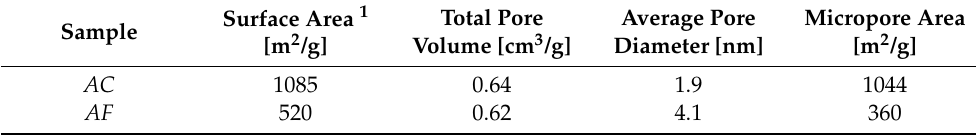
Table 3. Textural parameters of the activated carbon samples obtained.